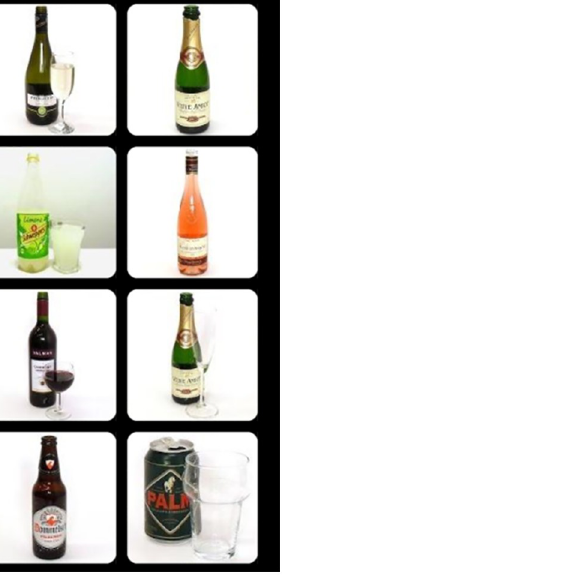
distractors) from the mean reaction time of the neutral target in neutral distractors trials (i.e., non-alcoholic drinks target in flowerpot distractors or flowerpot target in non-alcoholic drinks distractors). Higher positive scores were expected to reflect more attentional engagement with alcohol cues. Difficulty to disengage (i.e., disengagement index) was calculated by subtracting the mean reaction time of the neutral target in neutral distractors trials from the mean reaction time of the alcohol distractors trials (i.e., non-alcoholic drinks target or flowerpot target in alco- hol distractors). Higher positive scores reflected more difficulty to disengage attention from alcohol cues.